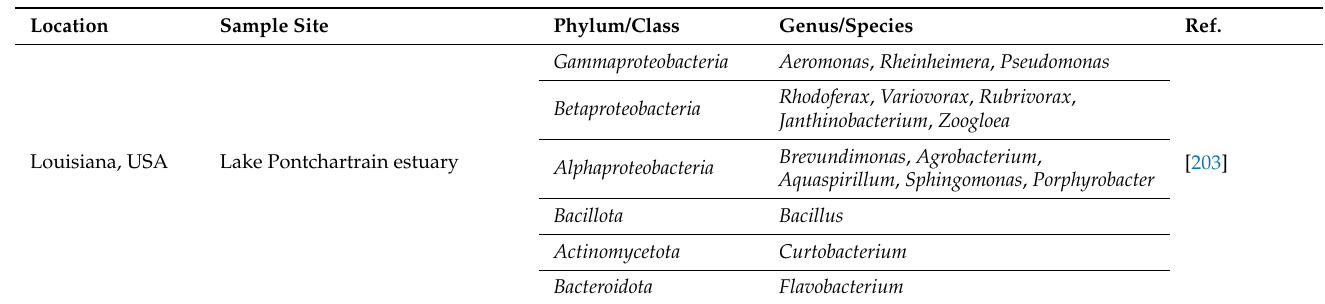
Table 1. The ecology of arsenic and selenium-resistant bacteria in different contaminated